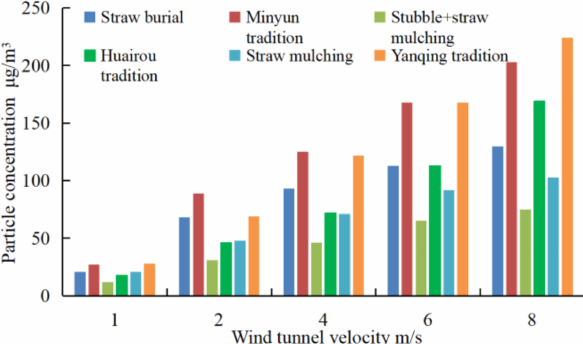
Figure 24. Changes of PM10 concentrations at 20 cm height under different wind